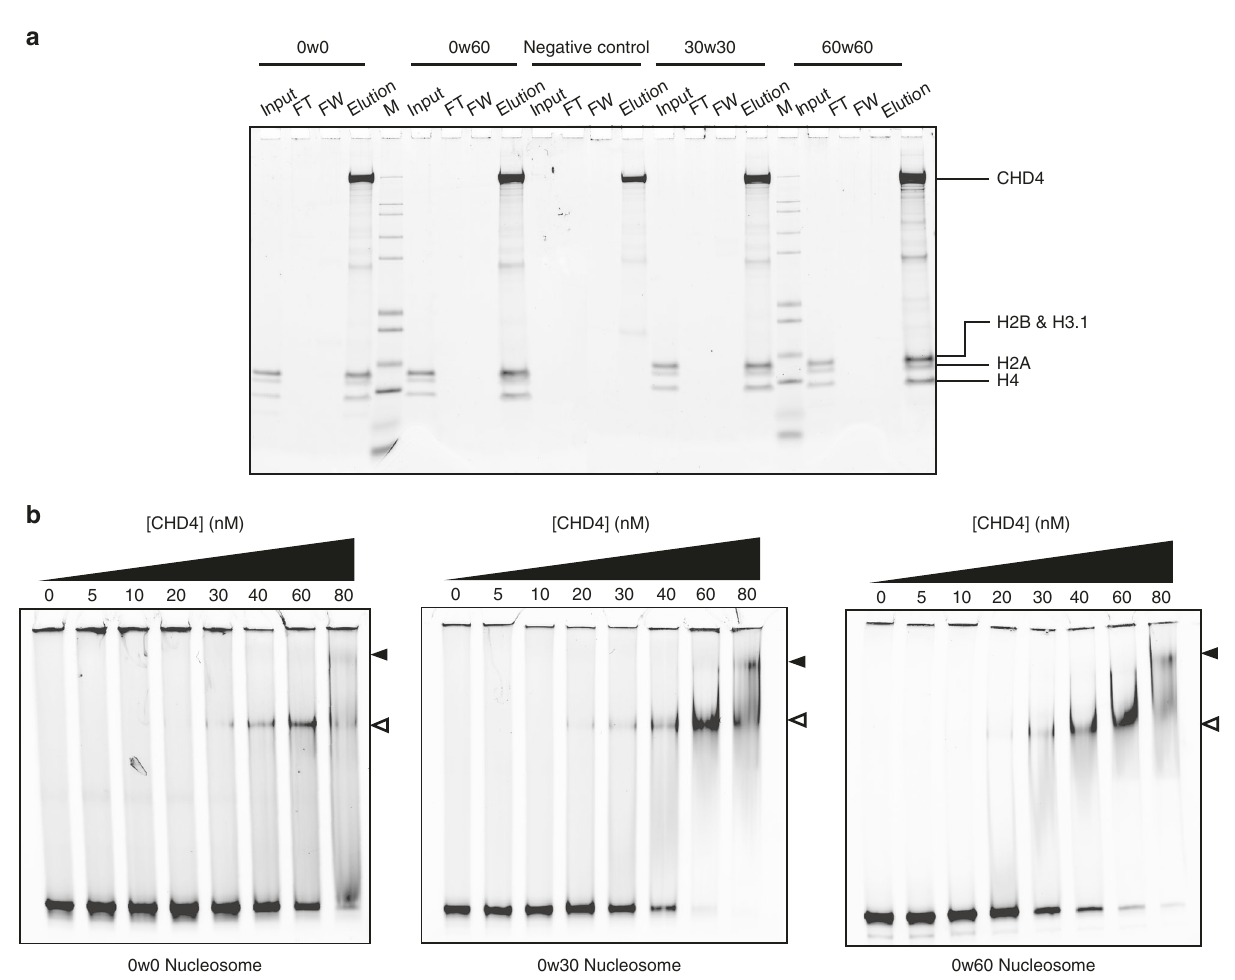
Fig. 2 The af fi nity of CHD4 for DNA is not strongly dependent on the presence of fl anking extra-nucleosomal DNA. a Pulldowns in which FLAG-CHD4 is immobilized on FLAG-Sepharose beads and incubated with the indicated nucleosomes, followed by elution with FLAG peptide. Nucleosome input, unbound nucleosome/ fl ow through (FT), fi nal wash (FW) and elutions of each nucleosome construct were analysed by SDS-PAGE, along with a size indicator, Mark12 Standard (M). The negative control contains no nucleosome in the input. b EMSAs showing the binding of CHD4 to the indicated nucleosomes. Nucleosome concentration was 90 nM (0w0) or 60 nM (0w30 and 0w60). Open and fi lled triangles indicate complexes that probably contain one or two CHD4 molecules,